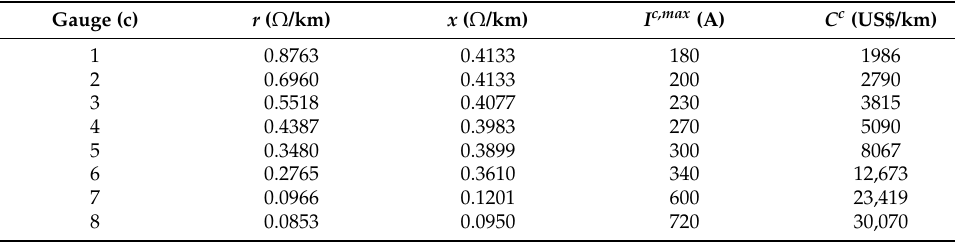
Table 8. Set of conductors considered for the different test systems.